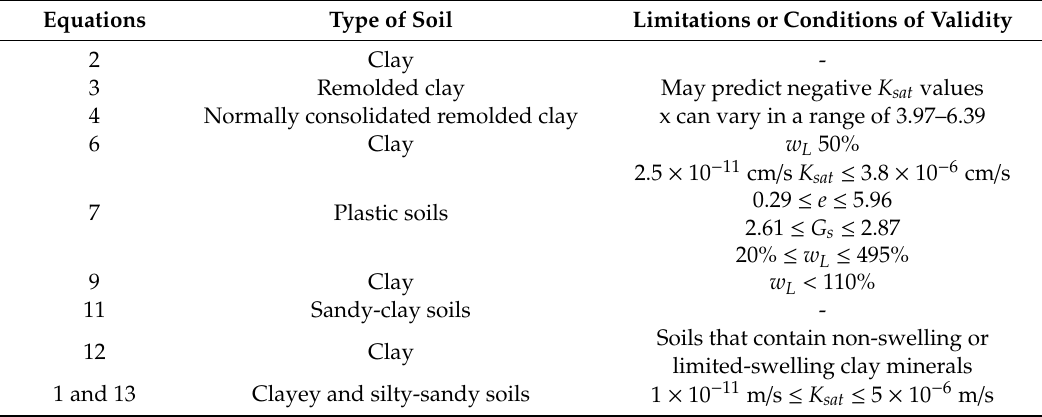
Table 1. Types of soils and limitations of predictive methods for K sat